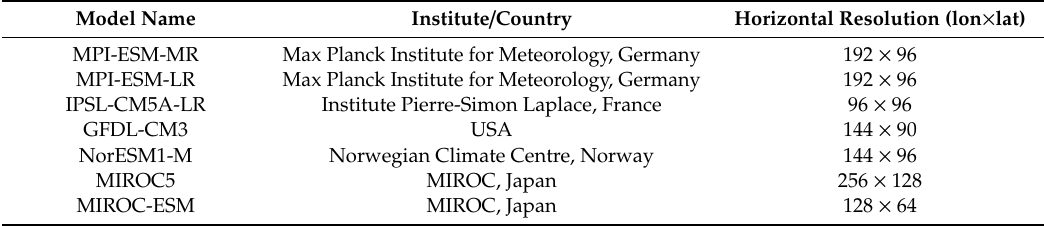
Figure 3. Sub-sets of the four selected General Circulation Model (GCMs) (color-filled markers) under representative concentration pathway (RCP) 4.5 and RCP 8.5 found by the k-means clustering method from a total of 26 GCMs (non-color-filled markers). These are based on the standard changes in temperature and precipitation simulated by GCMs between the 2003–2012 and the 2041–2050 periods. Table 2. Seven General Circulation Model simulations’ details of